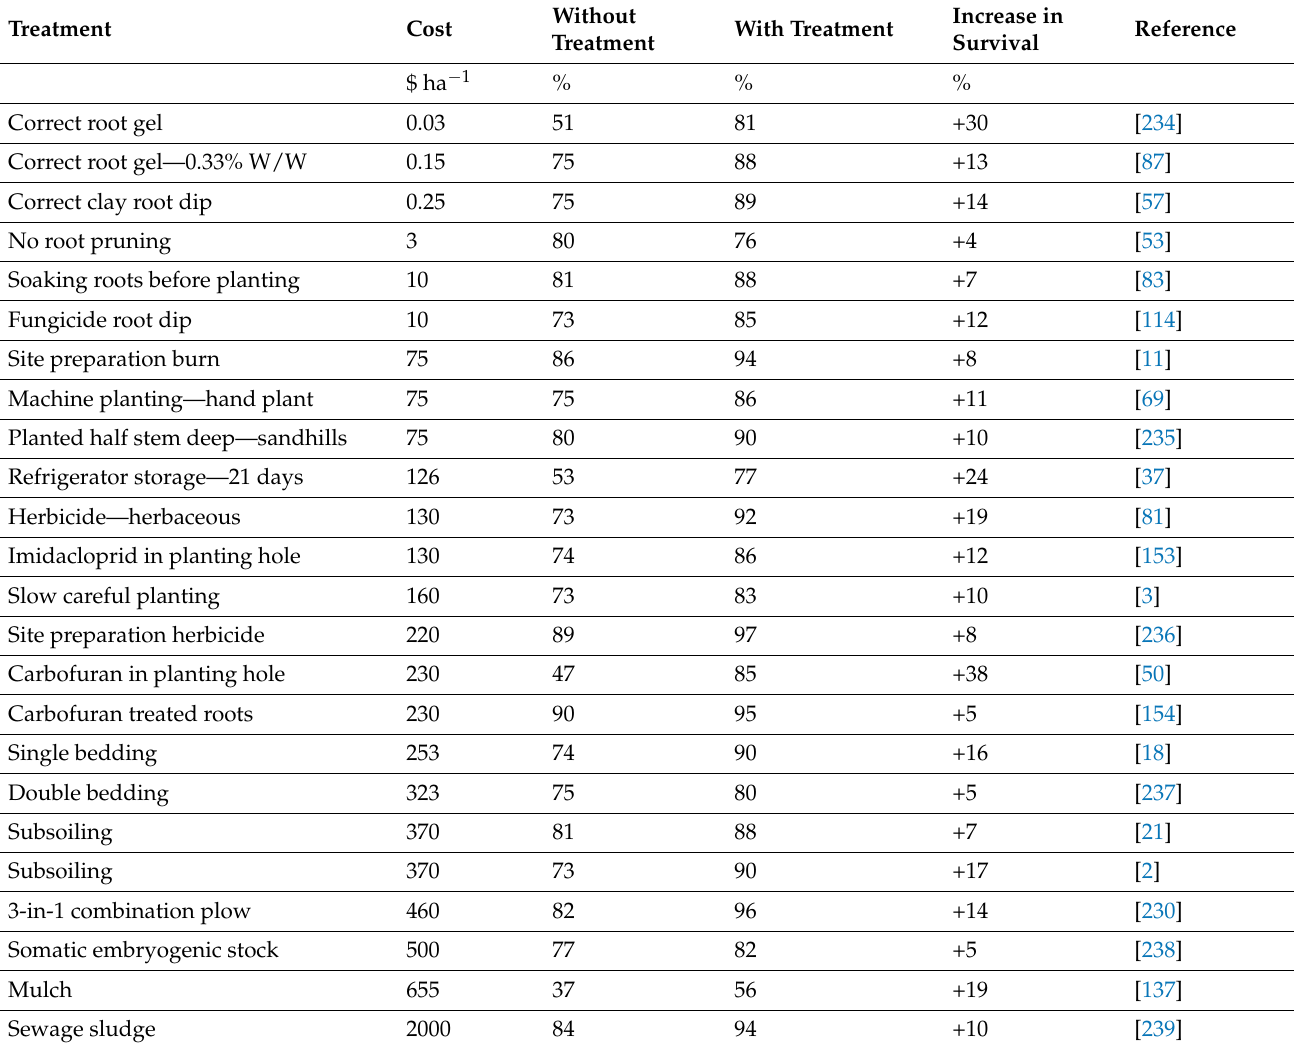
Table A2. Estimated cost of treatments that increase survival at 1000 seedlings ha − 1